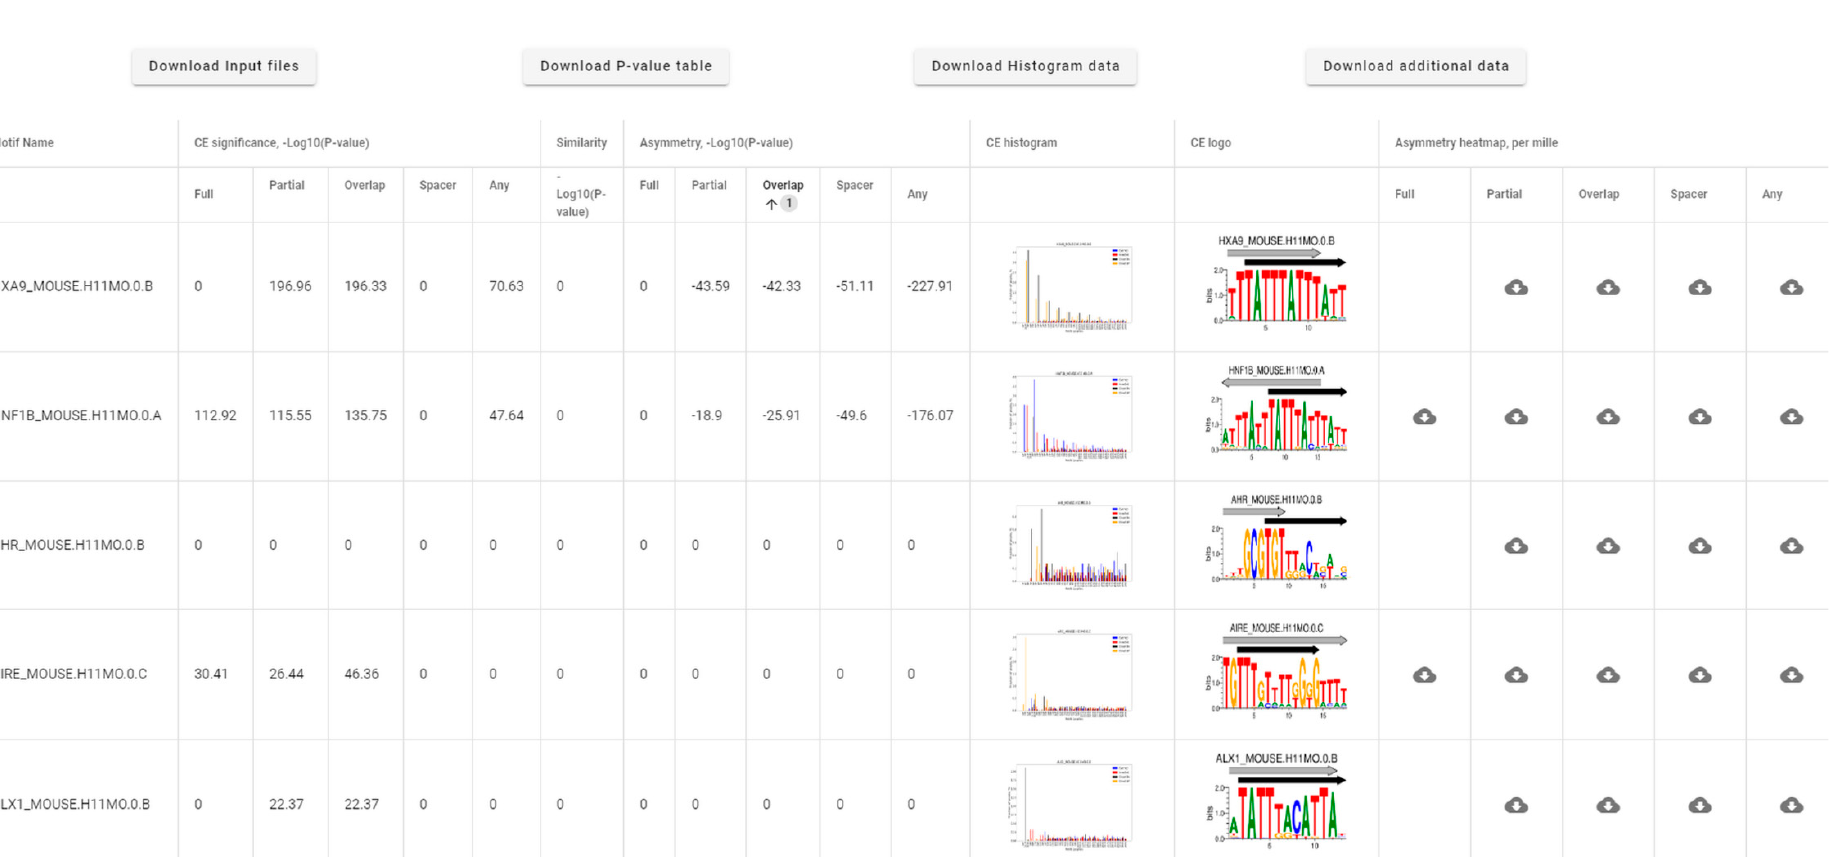
Figure 2. Basic output table of Web-MCOT for the example FoxA2 ChIP-seq dataset [18]. The first column lists the names of the second motifs in CEs. The common header ‘CE significance, − Log10( P-value )’ joins columns showing the significances of CEs without respect to motif conservation for five computation flows. The column ‘Similarity, − Log10( P-value )’ shows the significance of similarity of motifs. The common header ‘Asymmetry, − Log10( P-value )’ joins columns with the significances of asymmetry within CEs for five computation flows. The columns ‘CE histogram’ and ‘CE logo’ contain icons for histograms of CE abundance as a function of mutual orientation and location of the motifs, and for logos for the most common CE structural type with an overlap of motifs. The last five columns with the common header ‘Asymmetry heatmap, per mille’ respect five flows and show the links to heamaps of CEs abundance as a function of the ratios of conservation between Anchor and Partner motifs.